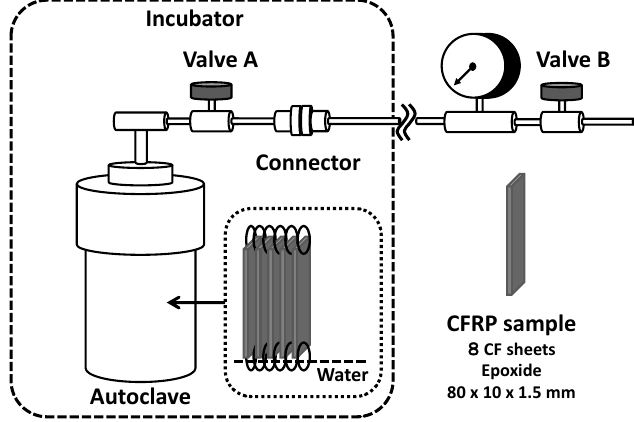
Figure 3. Stainless steel autoclave apparatus for accelerated ageing test for CFRP samples, subjected to moisture exposure and heating.